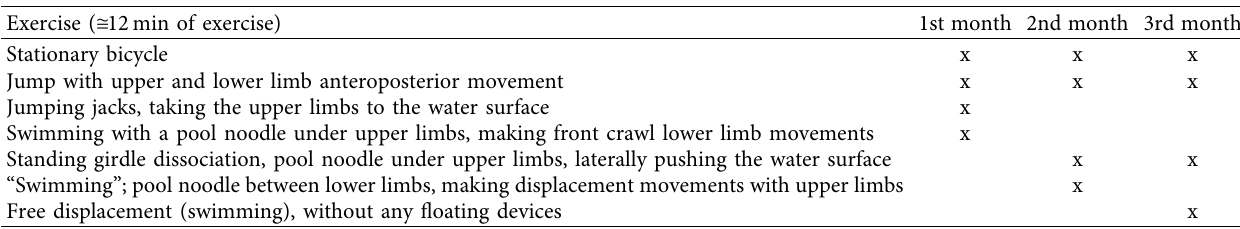
Table 4: Phase of global organic